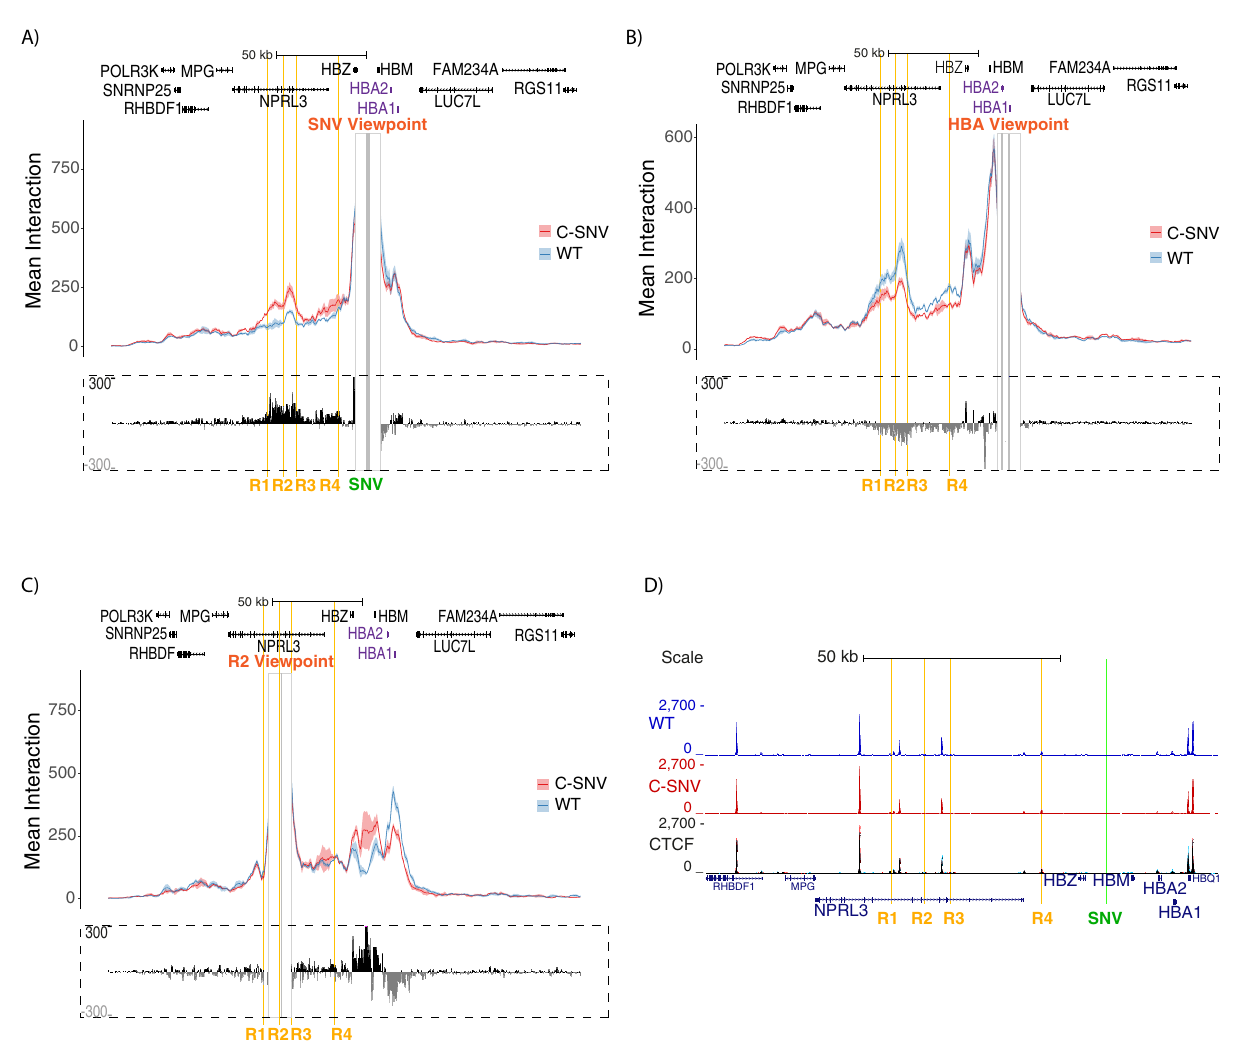
Fig. 3 New promoter sequesters interactions with the α -globin enhancers away from their cognate promoters. A Top panel shows overlaid, normalised Capture-C data for the novel promoter (SNV Viewpoint) in erythroid cells derived from 3 independent differentiation experiments: 3 biologically independent samples of wild type iPSC line AH017-13 (WT in blue) or 3 clones of C-SNV iPSCs obtained from the same patient material (C-SNV in red). The mean, plus and minus one standard deviation (S.D.), of sliding 5 kb windows are visualised as a dark coloured line and a lighter coloured shadow, respectively. Differential tracks (in dashed rectangle) show a subtraction (C-SNV minus WT) of the mean value of meaningful interactions per restriction fragment: positive values (in black) display an increase in interaction over a region in the mutant cells (C-SNV) compared to wild type, while negative values (in grey) indicate a decrease. The enhancer elements (R1 to R4) are highlighted in orange, the site of the T to C mutation is highlighted in green (SNV), gene annotation by Refseq is in black (except α -globin genes in purple). Coordinates (hg19) chr16:69,200-327,999. B Data presented as in A , viewpoint is promoters of HBA1 and HBA2. C Data presented as in A , viewpoint is enhancer R2. D ChIP-seq for CTCF, enhancer elements (R1 to R4) are highlighted in orange, the site of the T to C mutation is highlighted in green (SNV), gene annotation by Refseq is in blue. Read-densities represent an average of 3 independent differentiation experiments, 3 replicates for wild type iPSC line AH017-13 (WT in blue) or 3 C-SNV iPSC clones (C-SNV in red) differentiated to erythroblasts. The third track (CTCF) displays WT and C-SNV overplayed, black indicates shared signal while red and blue indicate signal unique for the mutant and wild type lines, respectively. Coordinates (hg19)